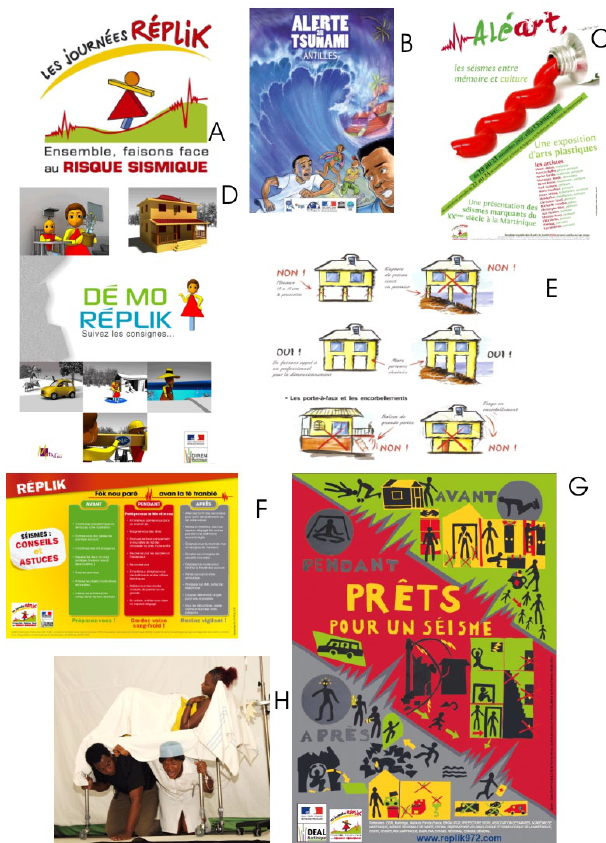
Fig. 3. Examples of R´eplik information supports. (A) The R´eplik logo since 2006; (B) tsunami leaflet; (C) arts exhibition “haz’arts”; (D) video series featuring a Martinican family; (E) simplified tech- nical brochure for construction; (F) magnet with dos and don’ts; (G) instructions poster drawn by children; (H) theatre skit of “Tran- blad” which means “shaking” in Creole (featuring an authentic childbirth during the 2007